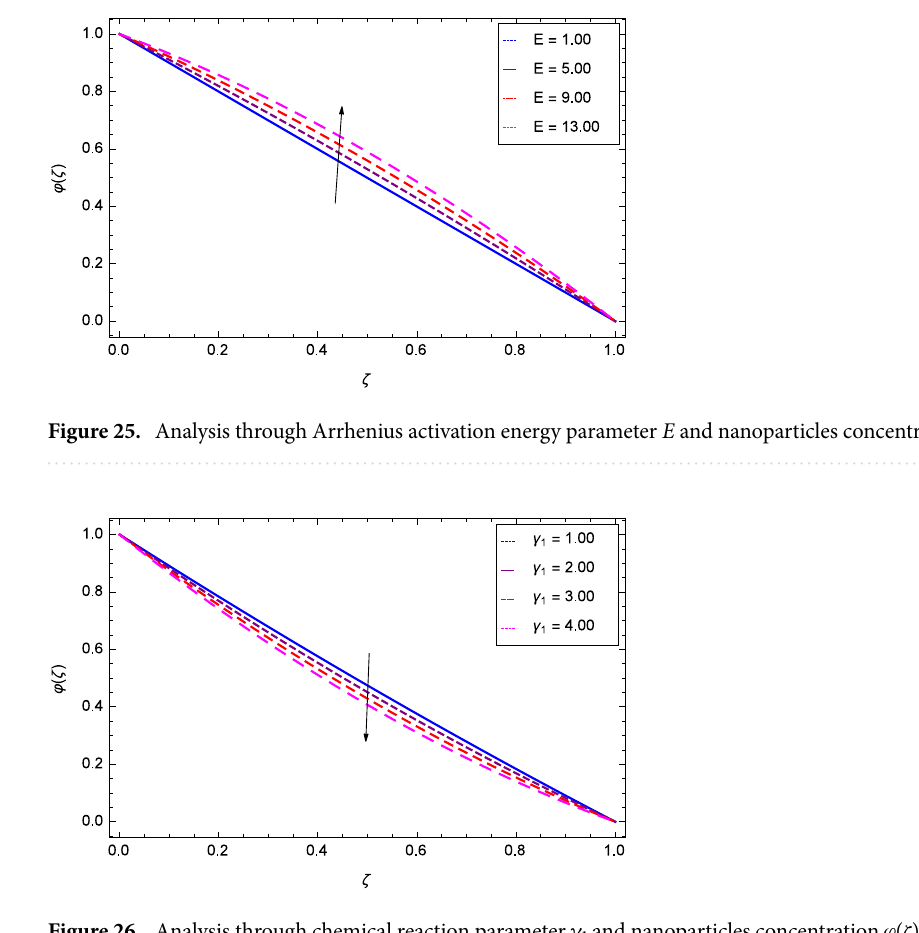
Figure 26. Analysis through chemical reaction parameter γ 1 and nanoparticles concentration ϕ ( ζ